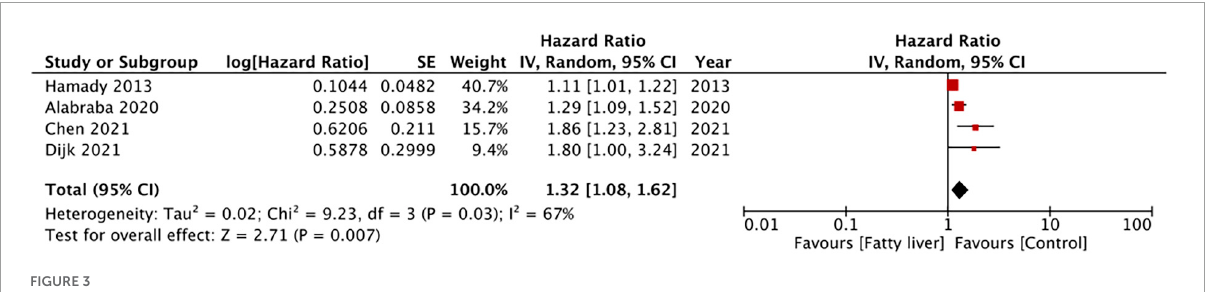
FIGURE3 Meta-analysis of the impact of hepatic steatosis on DFS in CRLM.